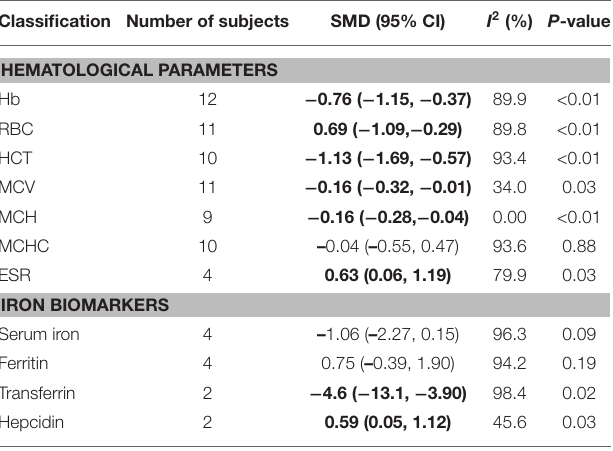
TABLE 2 | Meta-analysis of the association between periodontitis and the risk of anemia. Classification Number of